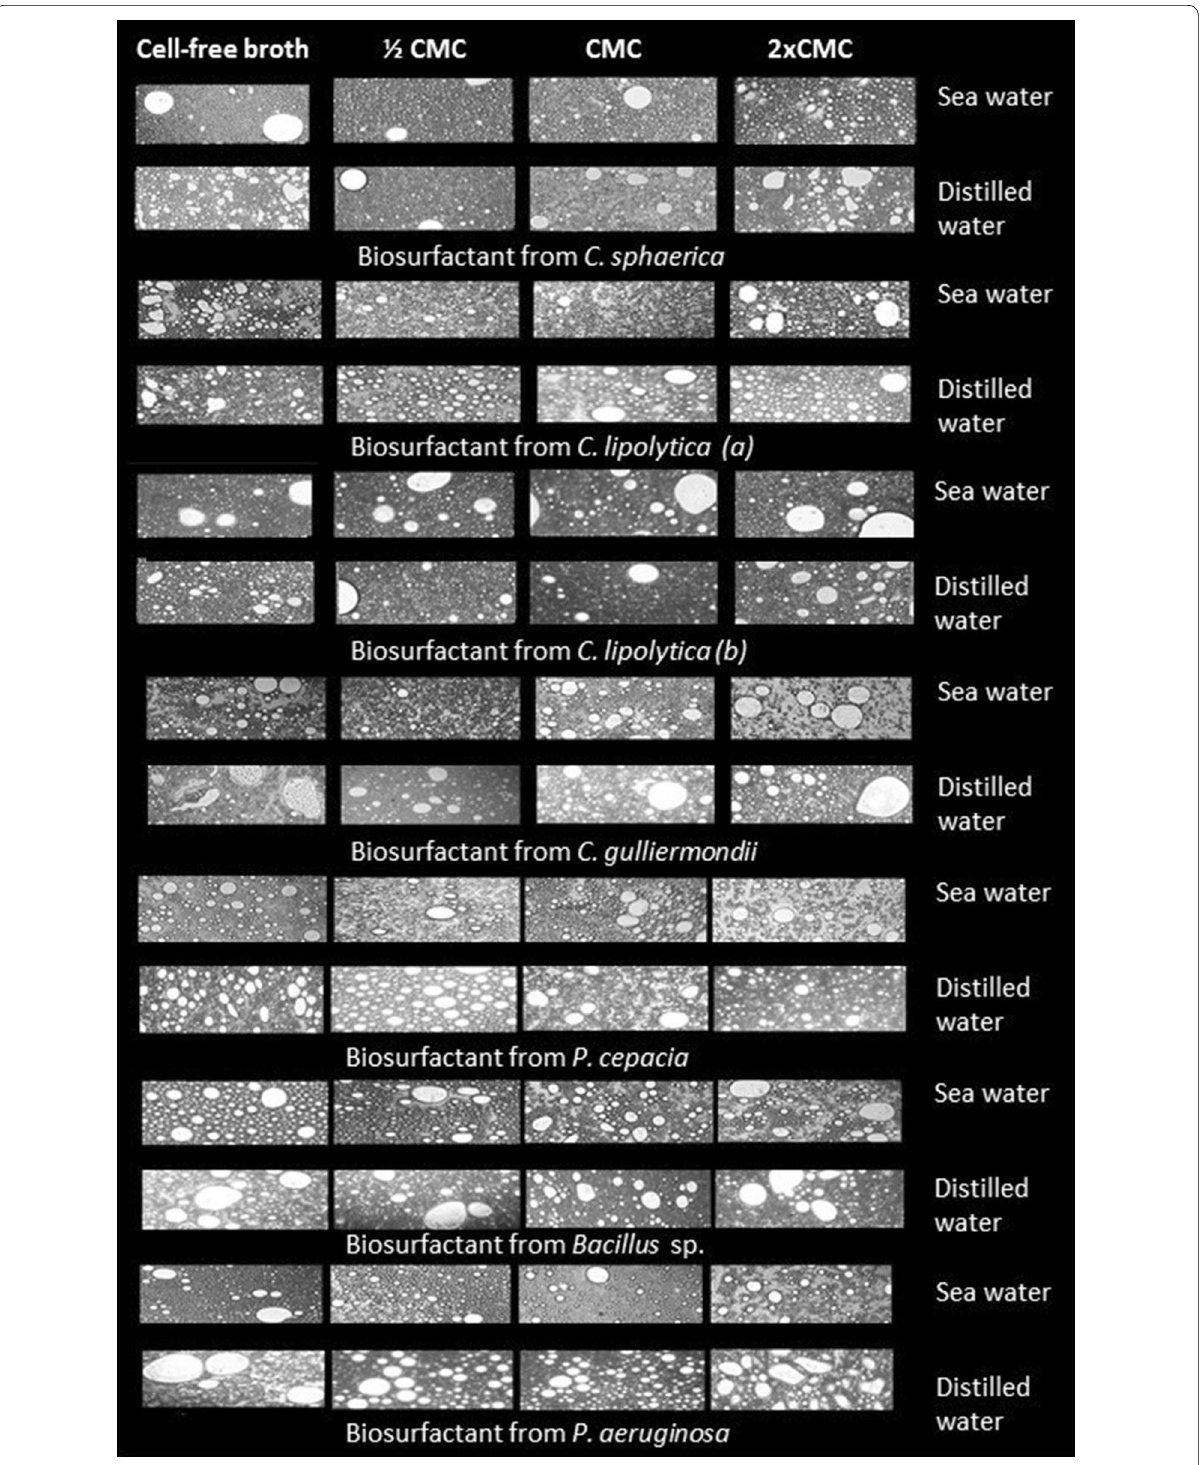
Fig. 3 Microscopy ( 40 magnification) of the residual motor oil emulsions in sea water and distilled water with the crude (cell-free broth) and the × isolate biosurfactants (at ½ CMC, at the CMC and 2 CMC) at 24 h after initiation of the demulsification ×